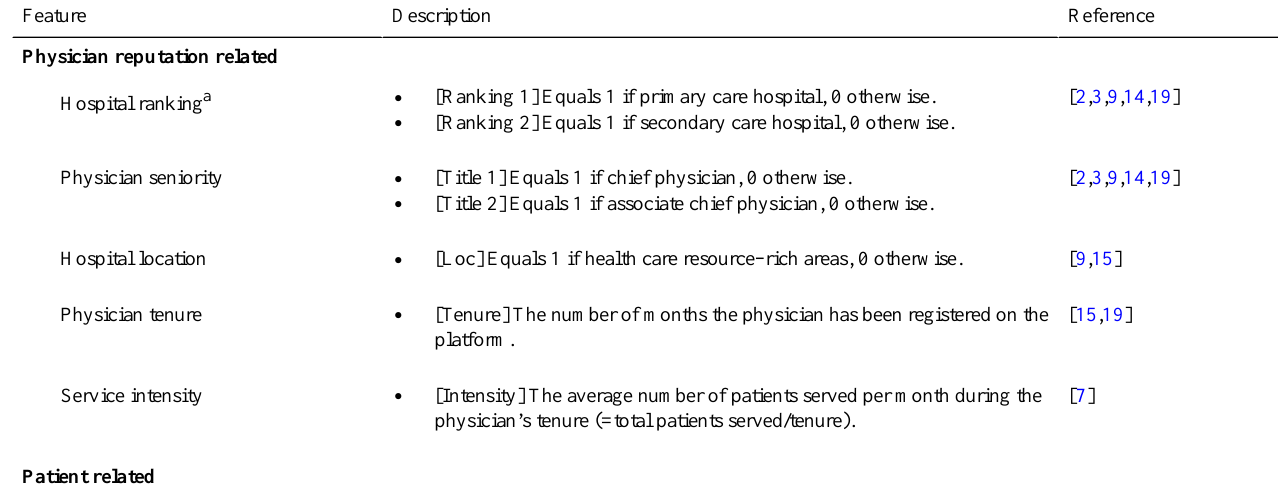
Table 1. Key predictive features and coding